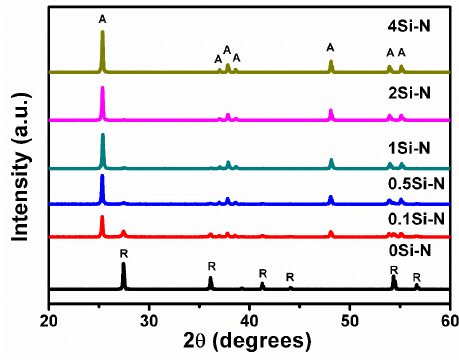
Figure 3. Influence of Si-content on the crystalline structure of the Si, N co-doped samples and the Si-free sample 0Si-N (A: anatase TiO 2 , JCPDS#21-1272, R: rutile TiO 2 , JCPDS#21-1276).